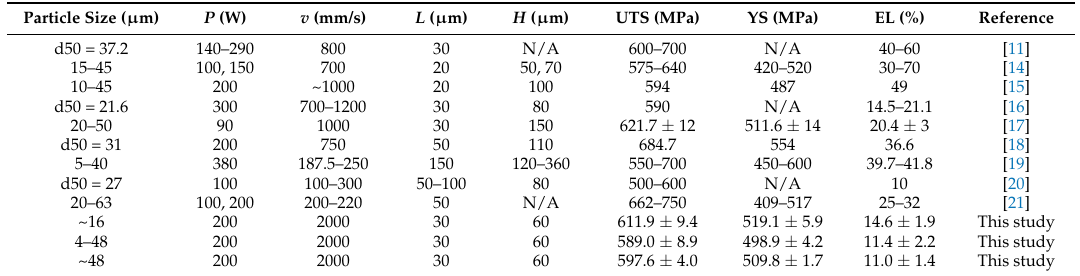
Table 2. Summary of tensile properties of prior work on SLM SS316L parts and this study.